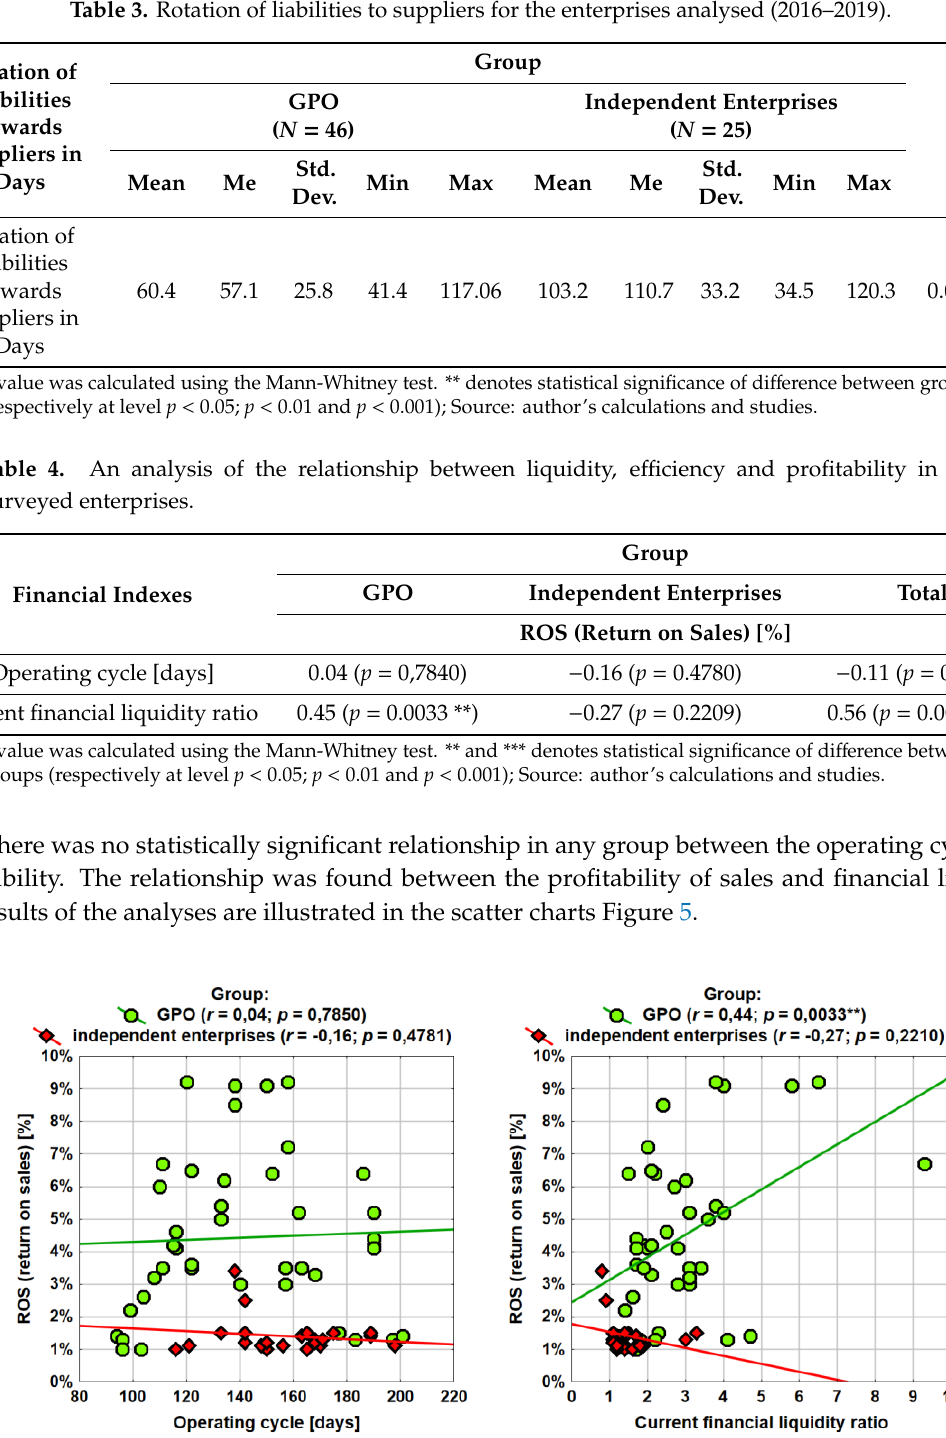
Figure 5. An analysis of the relationship between the operating cycle and profitability.